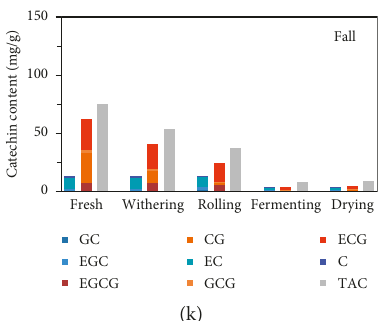
Figure 2: Changes of catechin components content of fresh leaf cultivars from different varieties, region and seasons during tea processing (mg/g). C: catechin; GC: gallocatechin; EGC: epigallocatechin; EC: epicatechin; ECG: epicatechin gallate; GCG: gallocatechin gallate; CG: catechin gallate; EGCG: epigallocatechin gallate; TSC: total simple catechins; TETC: total ester-type catechins; TAC: total amount of